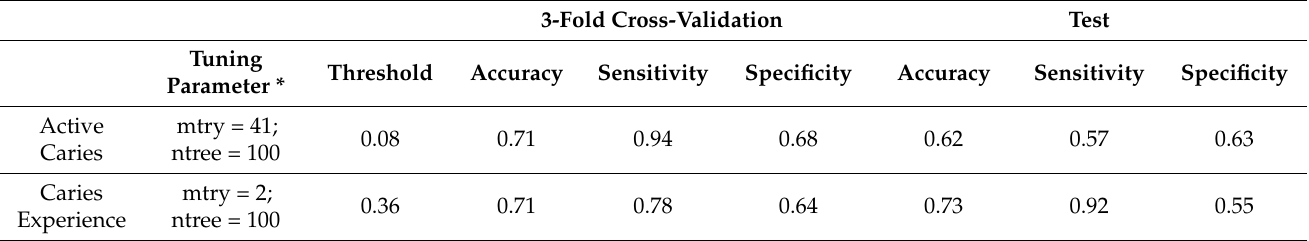
Table 1. Random forest performance on cross-validation sets and testing sets for active caries and caries